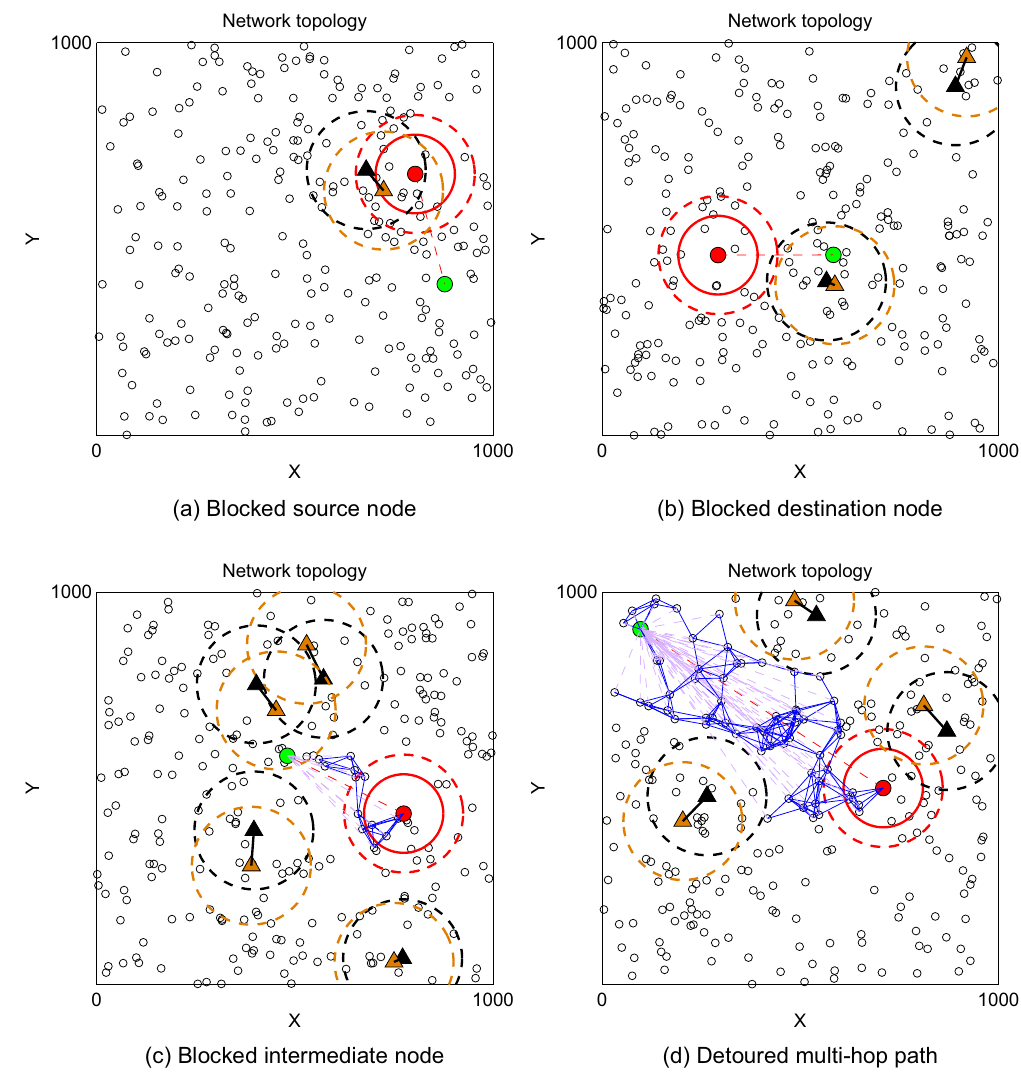
Figure 9. Illustration of multi-hop communication between two SUs in CRAHNs. a = 1000 m, N S = 250, N P = 5, λ P = 0.5, R T = r T = 250 m, R I = r I = 280 m.